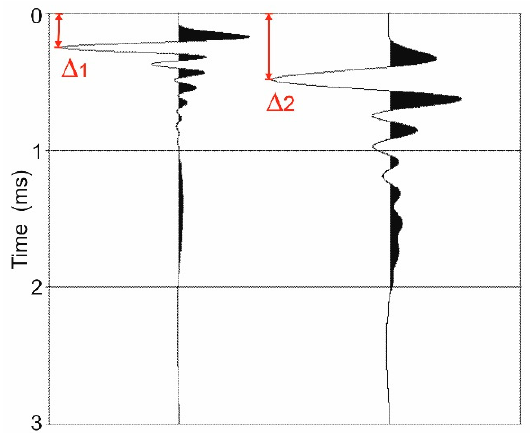
Figure 5. Two minimum-phase Butterworth wavelets with different bandwidths: 300–9000 Hz ( left ) and 300–4500 Hz ( right ). The time delay Δ 1 of the main peak from the time origin is about half of the delay Δ 2 of the second trace.